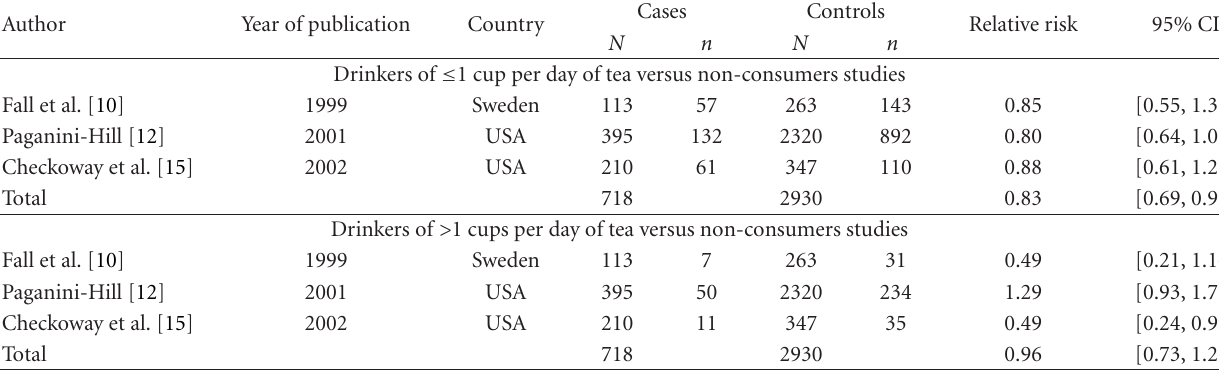
Table 2: The dose e ff ect relationship of tea drinking and PD risk.